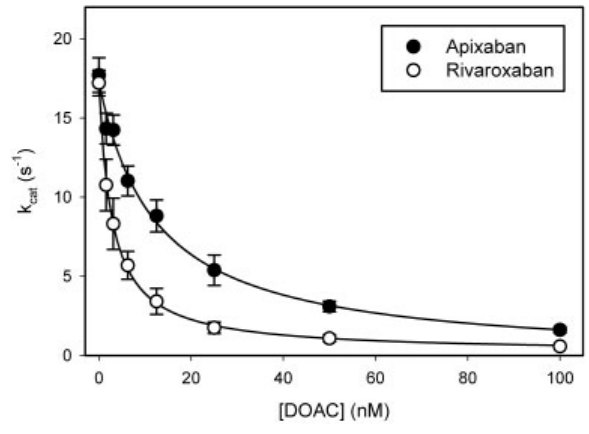
Fig. 4 Comparison of the effects of rivaroxaban and apixaban on prothrombin activation by prothrombinase. Inhibition constants (K i ) were determined by incubating increasing concentrations of rivar- oxaban ( open ) or apixaban ( closed ) with 0.5 nM factor Xa, 5.5 nM factor Va, 50 µM PCPS, 500 nM prothrombin, and 5 mM CaCl 2 . After 20 s, reactions were stopped by addition of EDTA to 10 mM and generated thrombin was quanti fi ed by chromogenic assay with Chz- Th. Rates of prothrombin activation are plotted versus inhibitor concentration. Symbols re fl ect the mean (cid:3) SD of three to four experiments. Lines are fi t to a rectangular hyperbola equation by nonlinear regression analysis.